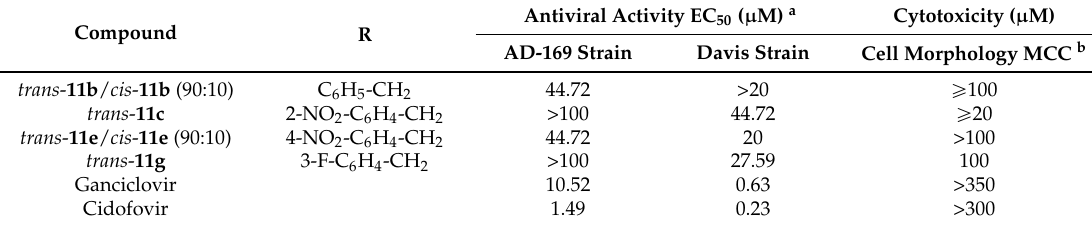
Table 3. Antiviral activity and cytotoxicity against human cytomegalovirus in HEL cell